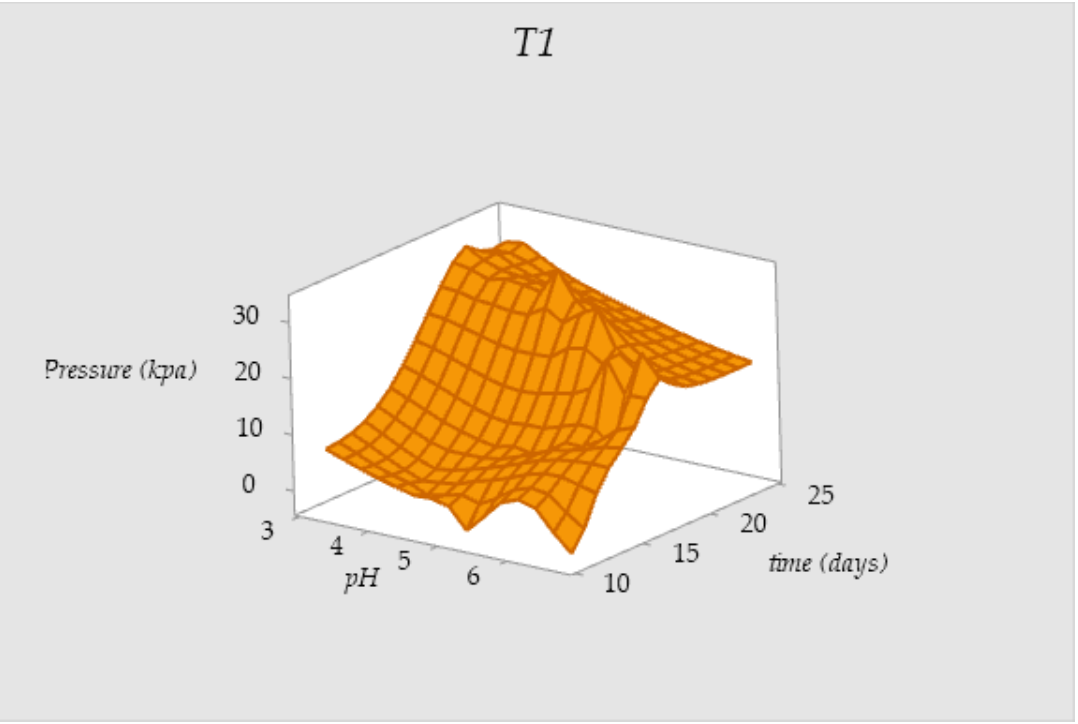
Figure 17. Behavior of pH and gas pressure over 25 days, in tank T1.